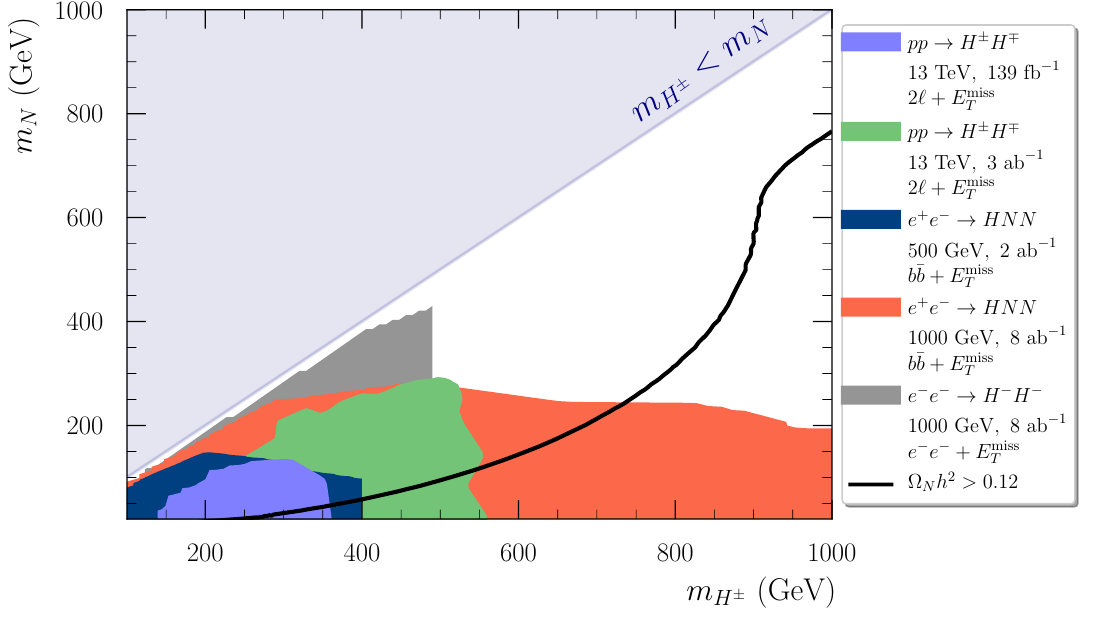
Figure 7 . A summary of the impact of the present and future colliders on the parameter space of our model projected on the plane of the charged Higgs mass ( m ) and the mass of DM ( m ). N H ± The shaded purple area shows the excluded parameter space from the re-interpretation of sleptons searches at the LHC with L = 139 fb − 1 . The green shaded region shows the extrapolations of the LHC limits to high luminosities ( L = 3000 fb − 1 ). The expected exclusions from mono-Higgs searches √ √ at the ILC at both s = 500 GeV and s = 1000 fb − 1 are shown in blue and red shaded areas respectively. Finally, the expected limits from searches of same-sign charged Higgs pair production √ at s = 1000 GeV are shown as gray contour. We show the contour satisfying Ω N h 2 = 0 . 12 as black line (the area below which is excluded). All these results were obtained assuming y = 2 and N ’ y e λ 3 = 1 . The bounds from Xenon1T experiment are